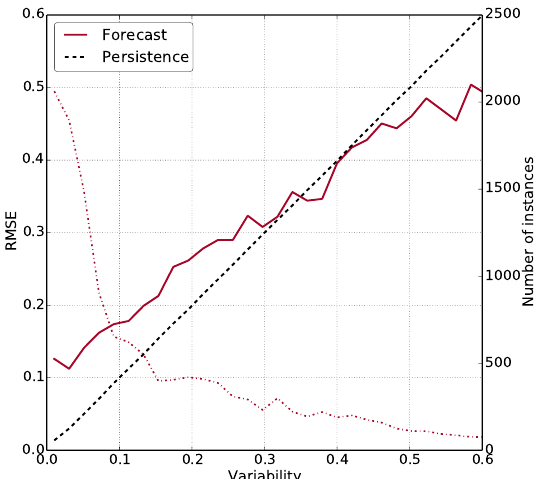
Figure 13. Forecast error (RMSE) vs. variability for pyranometer 33 located close to the camera (solid line). Persistence error (dashed line) is marked on the diagonal. The number of instances averaged in each bin with size k ∗ = 0 . 02 (dash-dotted line) is given on the right y axis to illustrate the